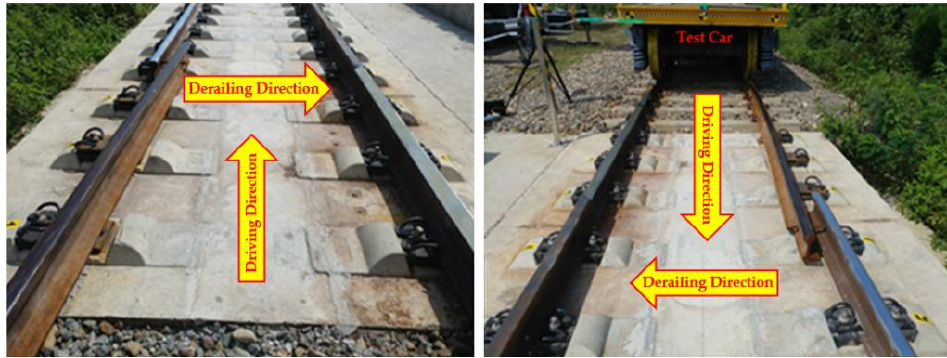
Figure 7. Derailer system.